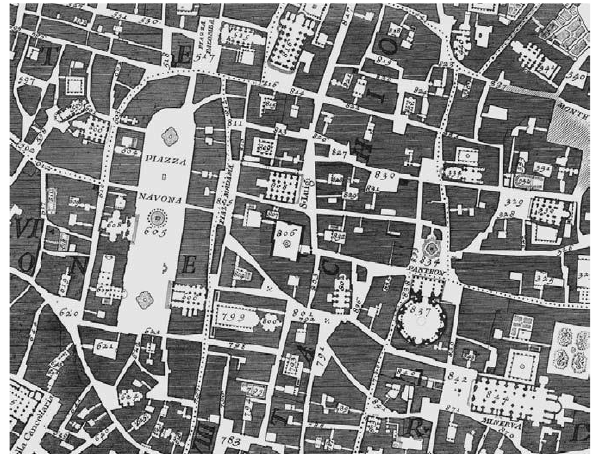
Figure 1. fragment of the 18th- century map of Rome by Giambattista Nolli (1748). Source; (Dhaene and De Cauter